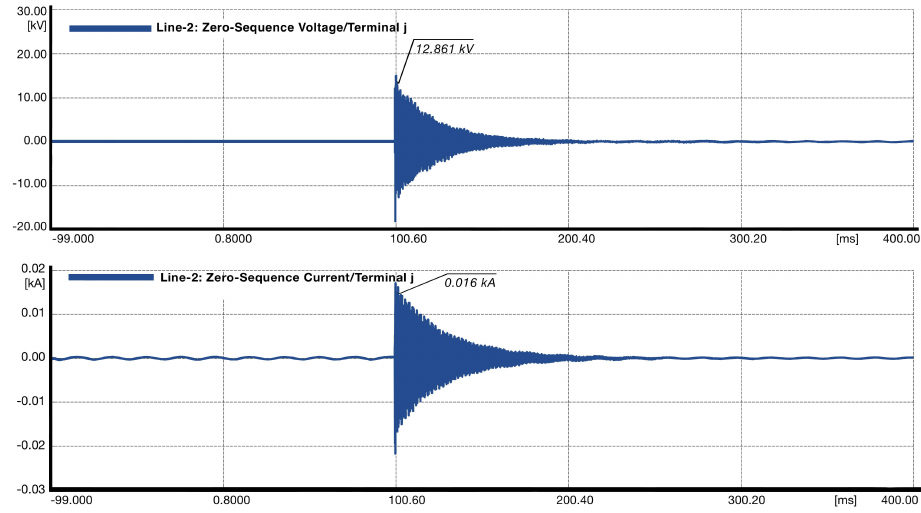
Figure 7. Three-phase voltages and currents for phase–ground fault.